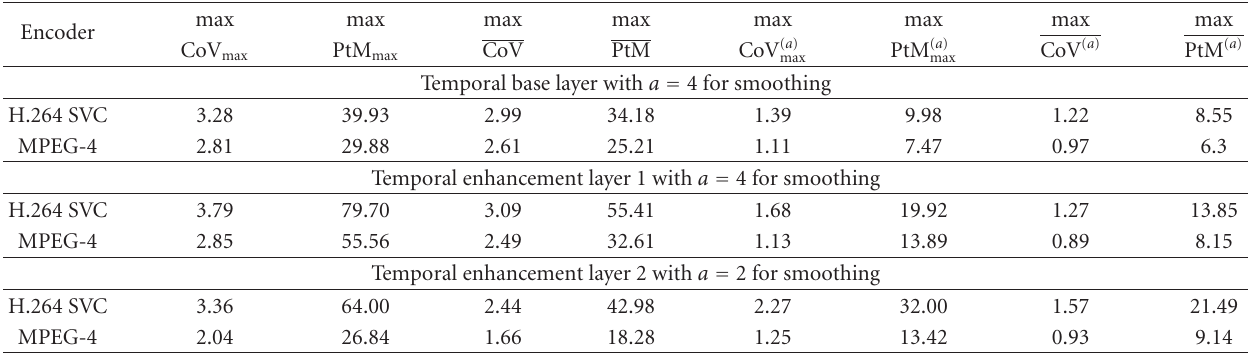
Table 3: Maximum (over quantization scales) of maximum (over video sequences), and maximum of mean CoV and PtM values of H.264 SVC and MPEG-4 Part 2 temporal base and enhancement layers (unsmoothed and smoothed ( a )).